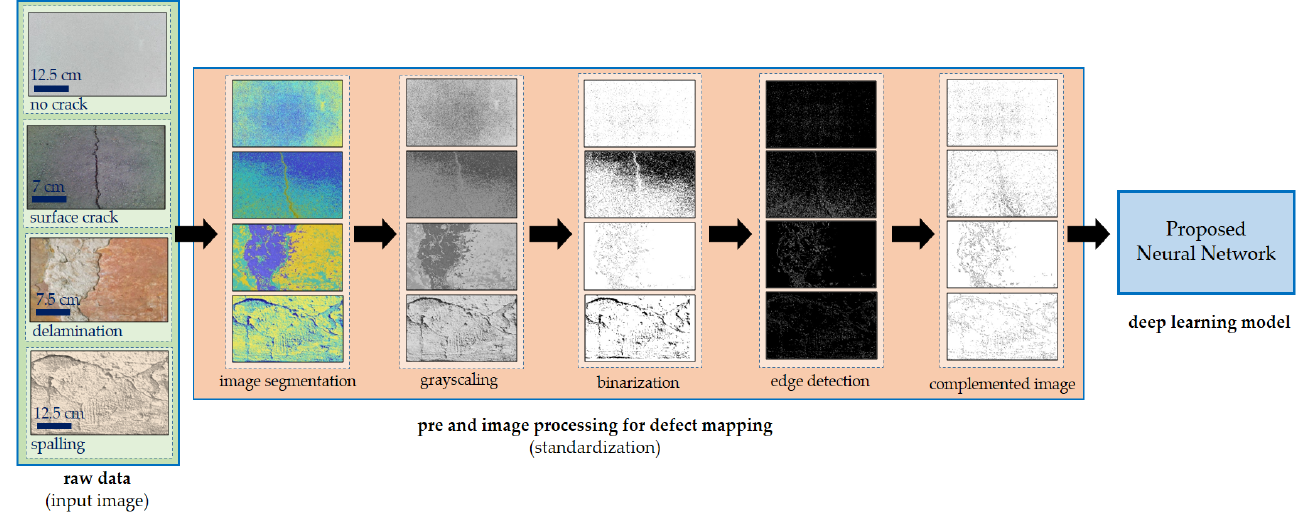
Figure 8. Proposed algorithm. Figure 8. Proposed